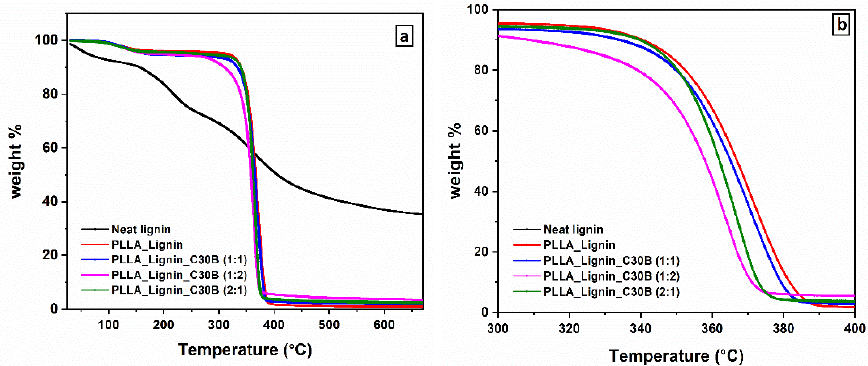
Figure 3. TGA profiles for PLLA with additive and nanocomposites. Influence of the lignin/filler ratio: ( a ) global profile (the TGA profile of lignin is added) ( b ) focus on the main degradation step. T 50% , T 90% , and T 95% are globally homogenous among materials, with the exception of PLLA_Lignin_C30B (2:1) and PLLA_Lignin_C30B (1:2). Both exhibit lower values of T 50% and T 90% compared to other systems, which is more surprising for PLLA_Lignin_C30B (2:1). We may assume that lignin, partly degraded, loses its stabilizing effect at these ad- vanced stages of pyrolysis. T 95% is curiously high in PLLA_Lignin_C30B (1:2). However, this result might be influenced by the nanofiller content that does not degrade, which may hinder the release of gases. Figure 4 gives the evolution of the MT-DSC average heat flow as a function of the temperature for all the samples, consecutive to cooling from the melt at 50 K min − 1 . The classical behavior obtained for neat PLLA was observed as follows: a heat-flow step of around 55–60 °C, corresponding to the glass transition; an exothermic peak with a maxi- mum at around 80 °C, corresponding to the cold crystallization; and an endothermic peak at around 170 °C, indicating the melting temperature. The addition of lignin brought about a remarkable change in the thermal behavior of the PLLA. Indeed, we observed that the amplitude of the heat-capacity step Δ Cp at the glass transition and the enthalpy of cold crystallization Δ H c were increased when the glass transition temperature T g shifted to lower temperatures. These changes are the signature of a greater amorphization during cooling. The degree of crystallinity X c , calculated according to Equation (2) and given in Table 1, confirms that the addition of lignin retards the PLLA crystallization. (cid:1850) (cid:3004) = ∆(cid:1834) (cid:3033) − Σ∆(cid:1834) (cid:3030) ∆(cid:1834) (cid:3033) °